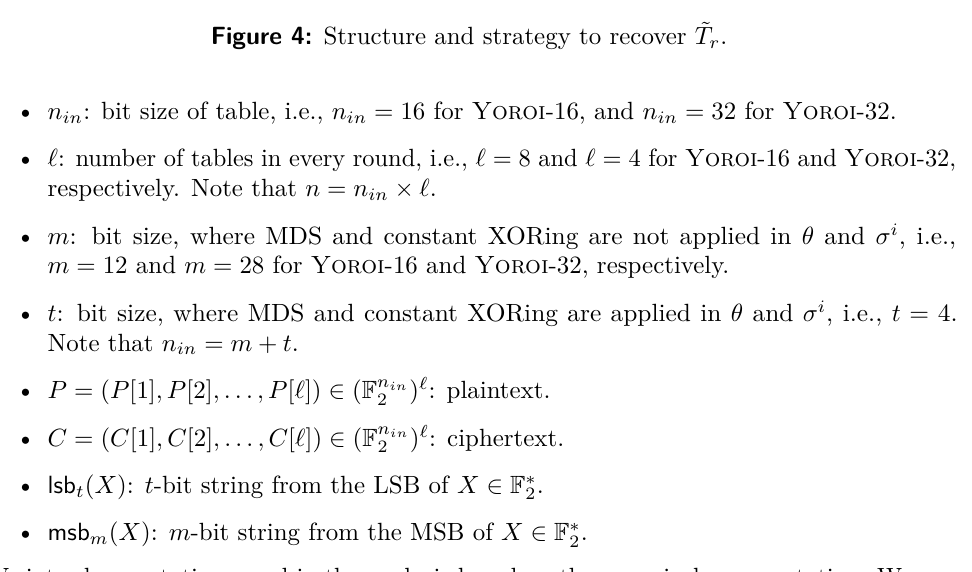
Figure 4: Structure and strategy to recover